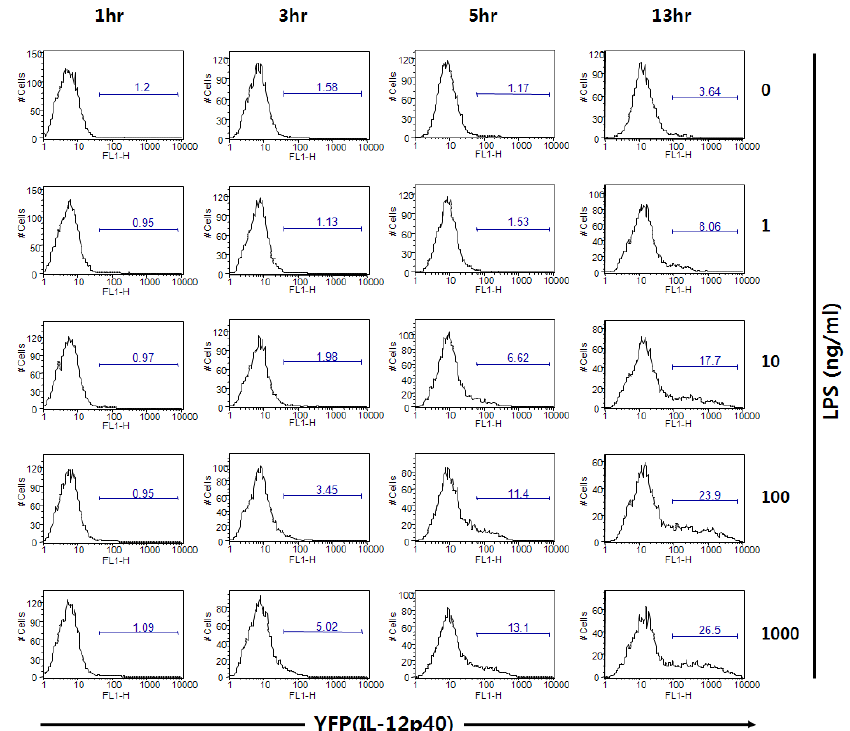
Figure 8. Dose-dependency and kinetics of IL-12 p40 induction by BMDCs upon stimulation with LPS. Flt3L-cultured BMDCs from IL-12 p40 reporter mice were incubated with LPS and analyzed for YFP by flow